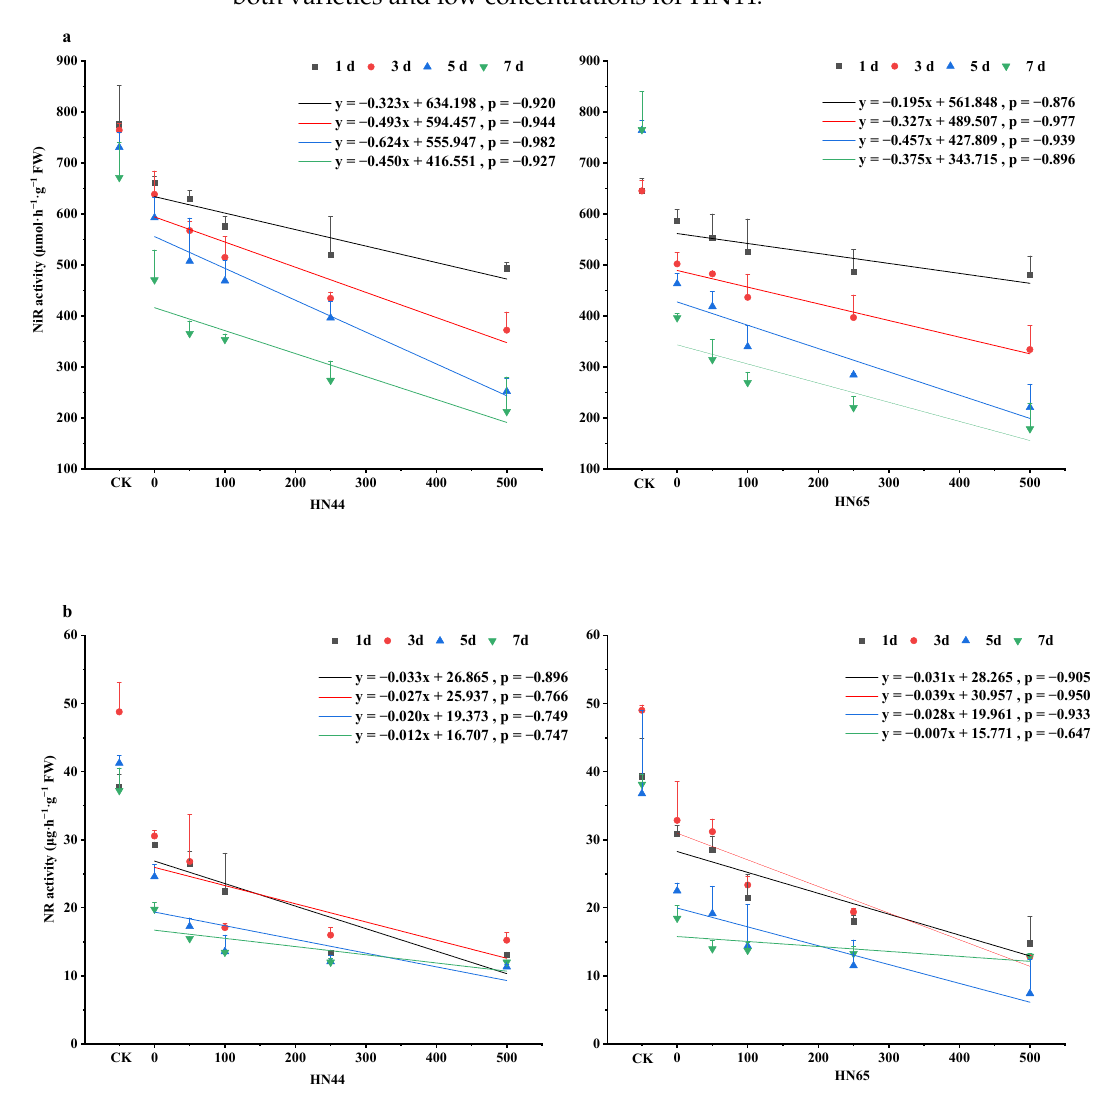
Figure 2. Changes in NiR and NR activities during NO mitigation of drought stress. ( a ) nitrite reductase (NiR) activity, ( b ) nitrate reductase (NR) activity. The X -axis, CK represents the control, and the remaining numbers are SNP concentrations sprayed. The Values (mean ± SE) are the averages of three independent experiments.